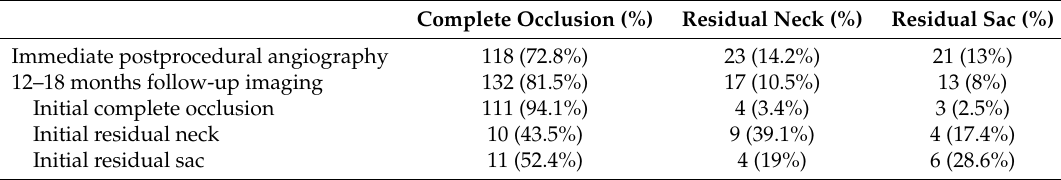
Table 2. Aneurysm occlusion rate immediately post-procedure and at 12–18 months follow-up imaging.